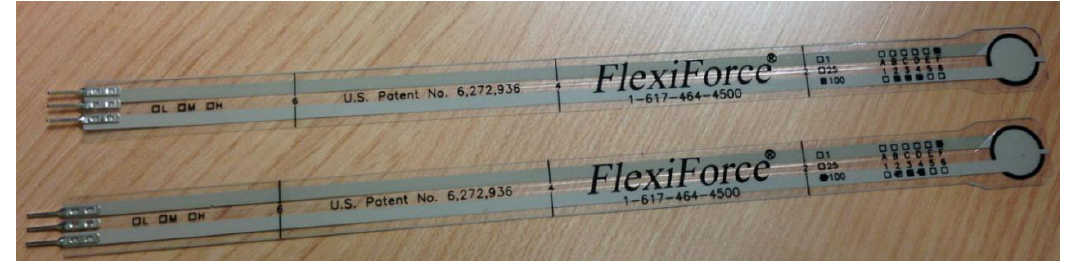
Figure 6. FlexiForce piezoresistive pressure sensor.